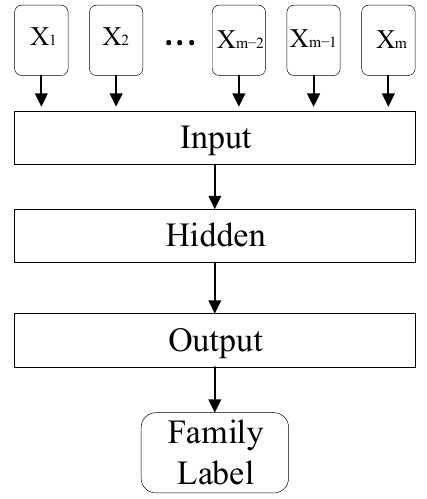
Figure 2. The construction of the shallow neutral network.